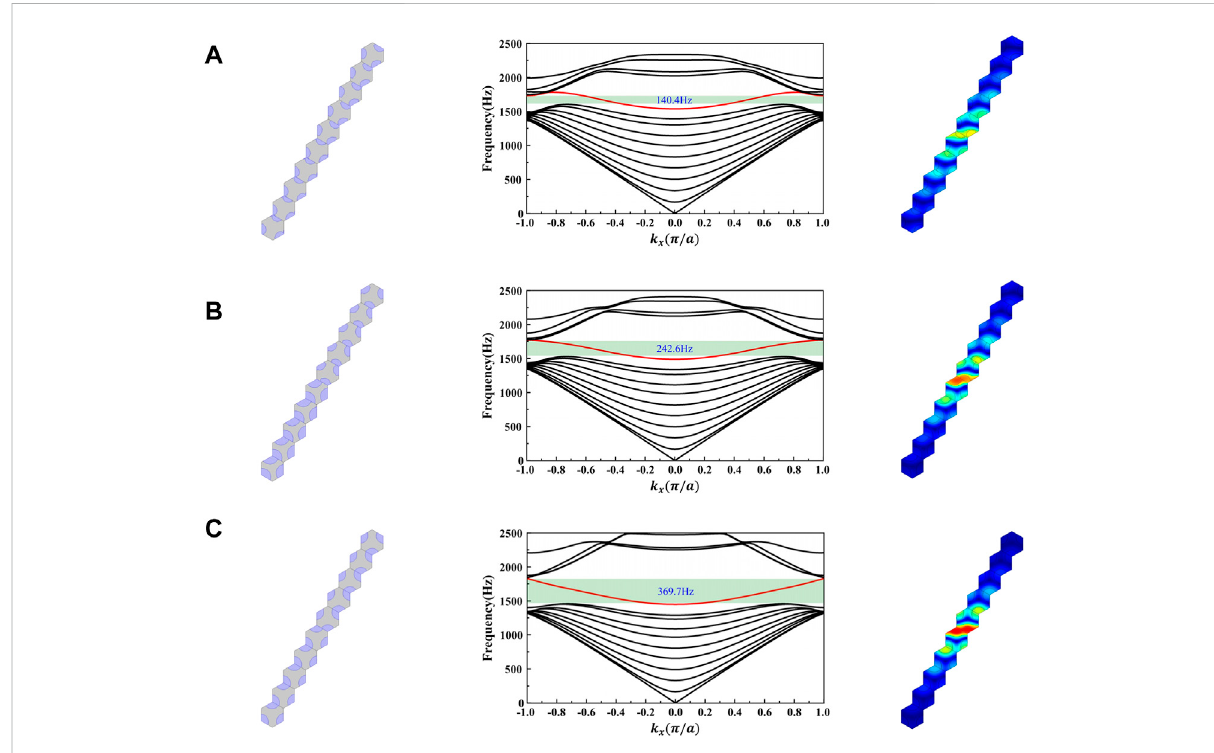
FIGURE 9 Optimized supercells, their band structures and the corresponding interface modes at k x (cid:2) 0 . 5 π / A with the width of common bandgap as (A) 0.04 (B) 0.07 (C) 0.105.